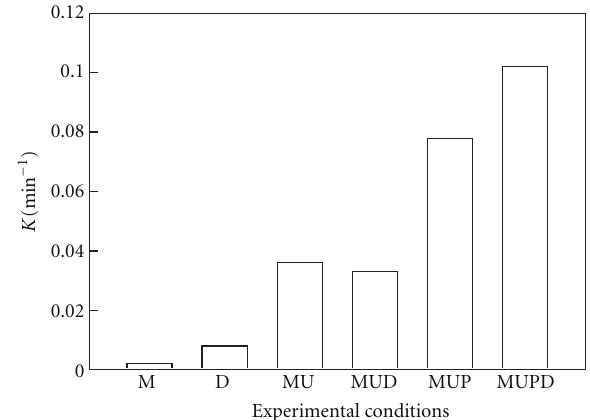
Figure 6: Rate constants obtained under di ff erent experimental